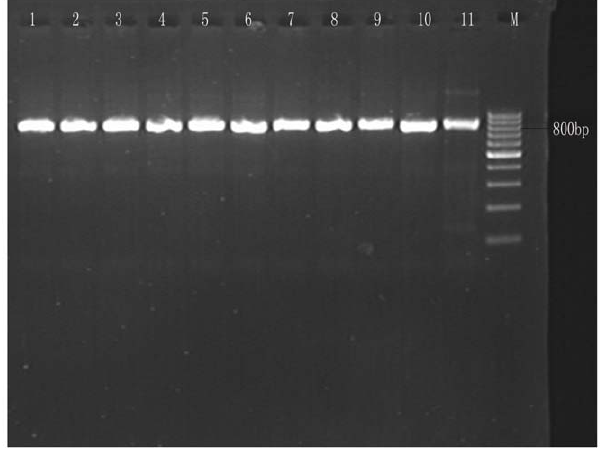
Figure 1. Agarose gel electrophoresis of Shanghai sequences. PCR amplification products of respective Cryptosporidium isolates were subjected to 2% agarose gel electrophoresis. Lane 1, positive control, lanes 2–11 18S rRNA amplification products and M, 100 bp DNA ladder. PCR products are approximately 840 bp.